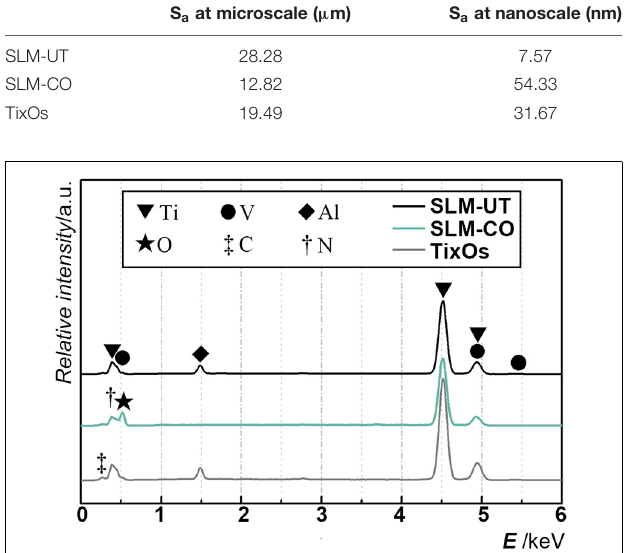
FIGURE 3 | The elements component of three implants, illustrated by the multi-curve-stack lines by Y offsets graph of energy-dispersive X-ray spectrometry.